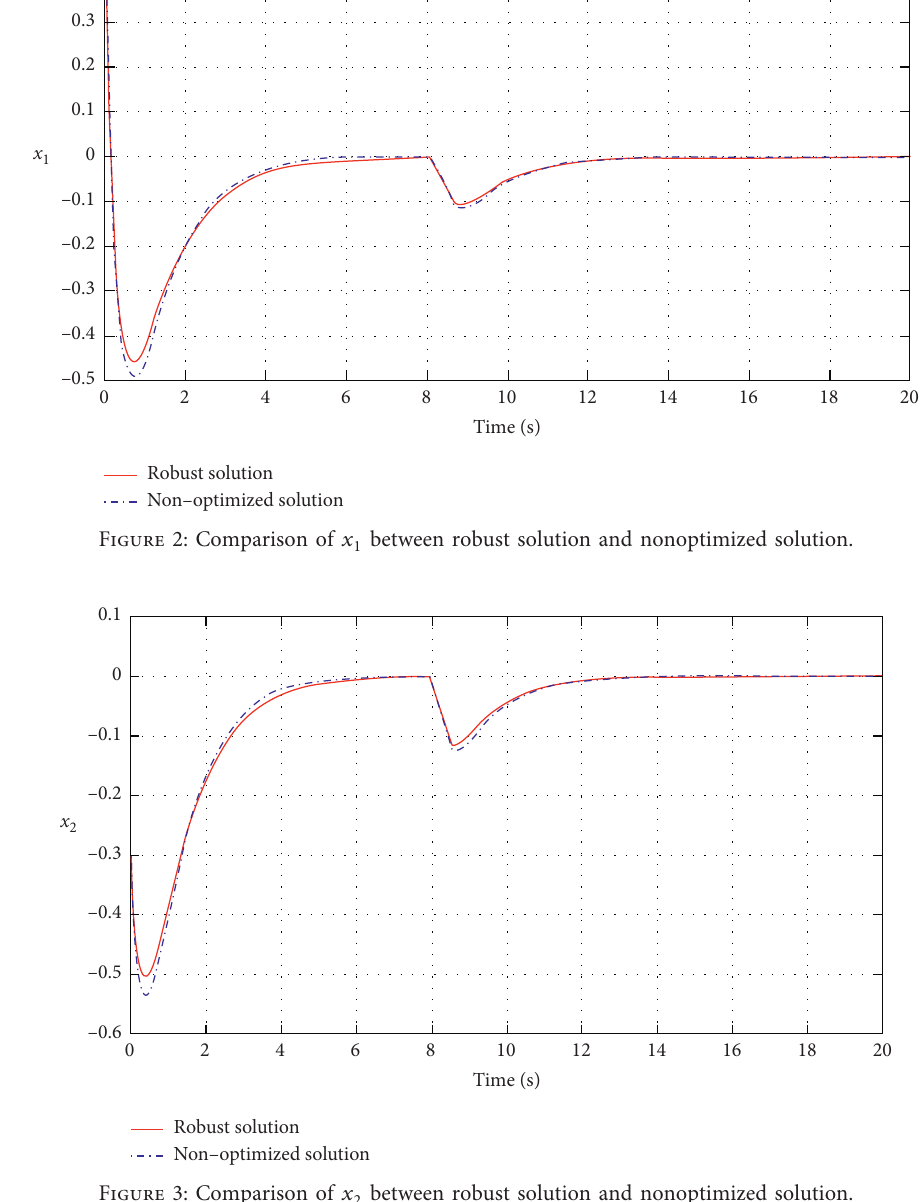
between robust solution and nonoptimized 2